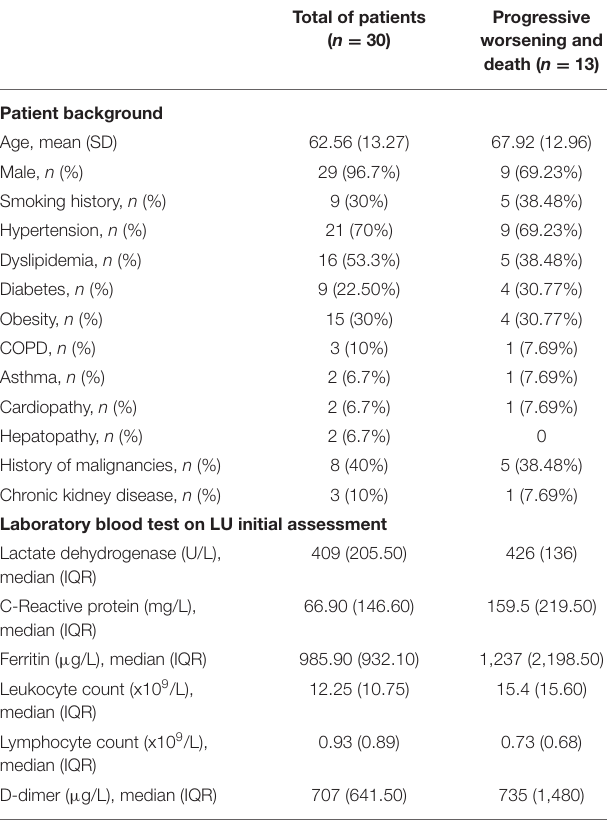
TABLE 1 | Demographic and clinical characteristics of patients at the time of evaluation according to lung ultrasound